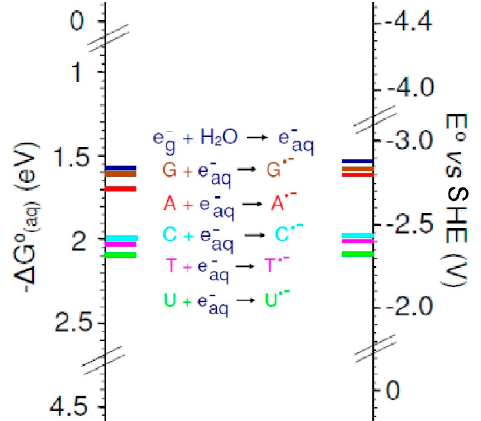
Figure 10. A comparison of the G4-calculated free energies of electron addition to water and various DNA bases, Δ G o(aq) (eV), along with E o versus SHE of all the bases and solvated electron indicated by colored bars on scales. The scales differ by 4.44 V. Reprinted with permission from reference [72]. Copyright, 2016, American Chemical Society.